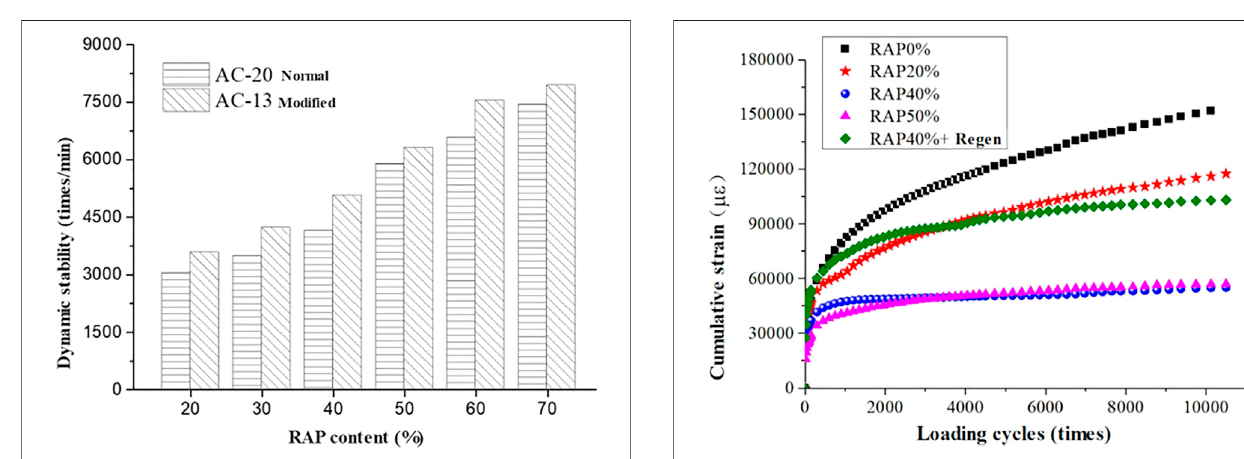
FIGURE 6 | Dynamic creep curves of fi ve different AC-13 modi fi ed asphalt recycled